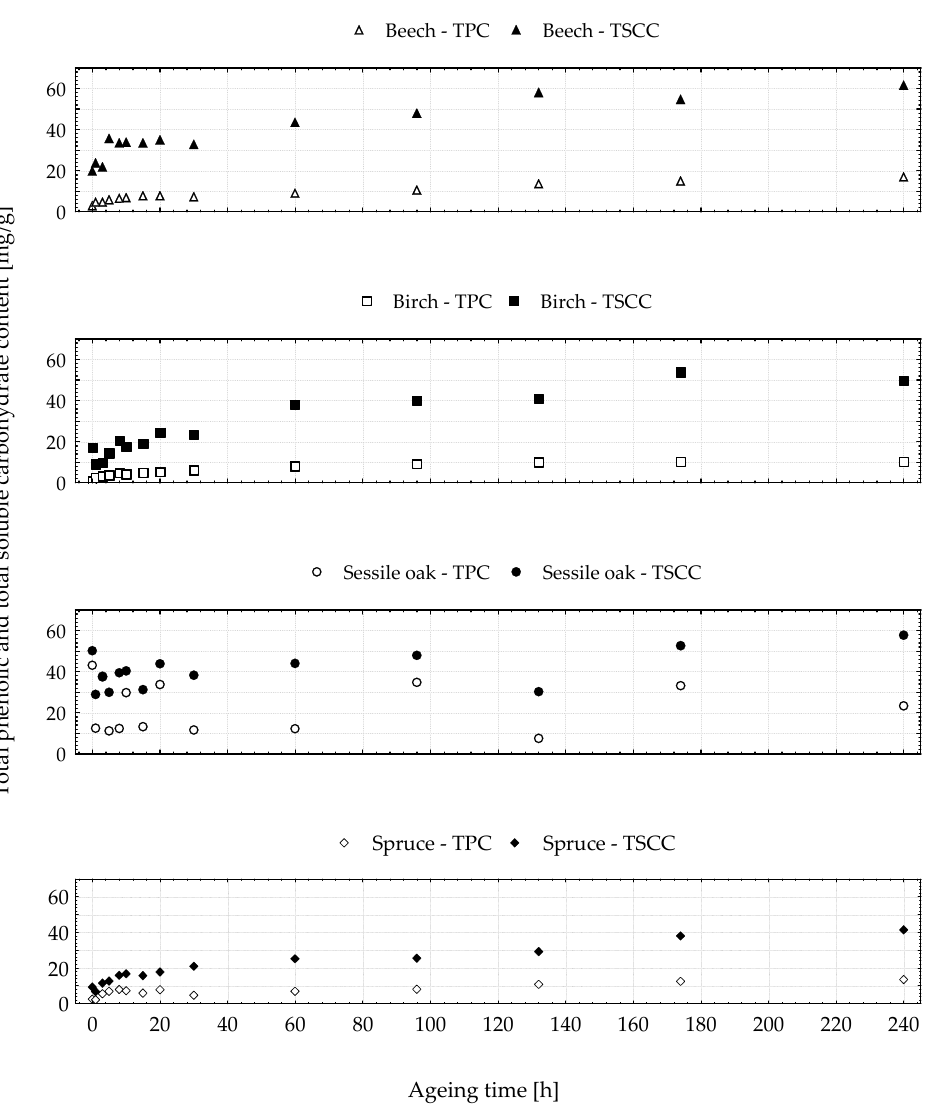
Figure 3. Total phenolic and total soluble carbohydrate contents as function of artificial ageing.